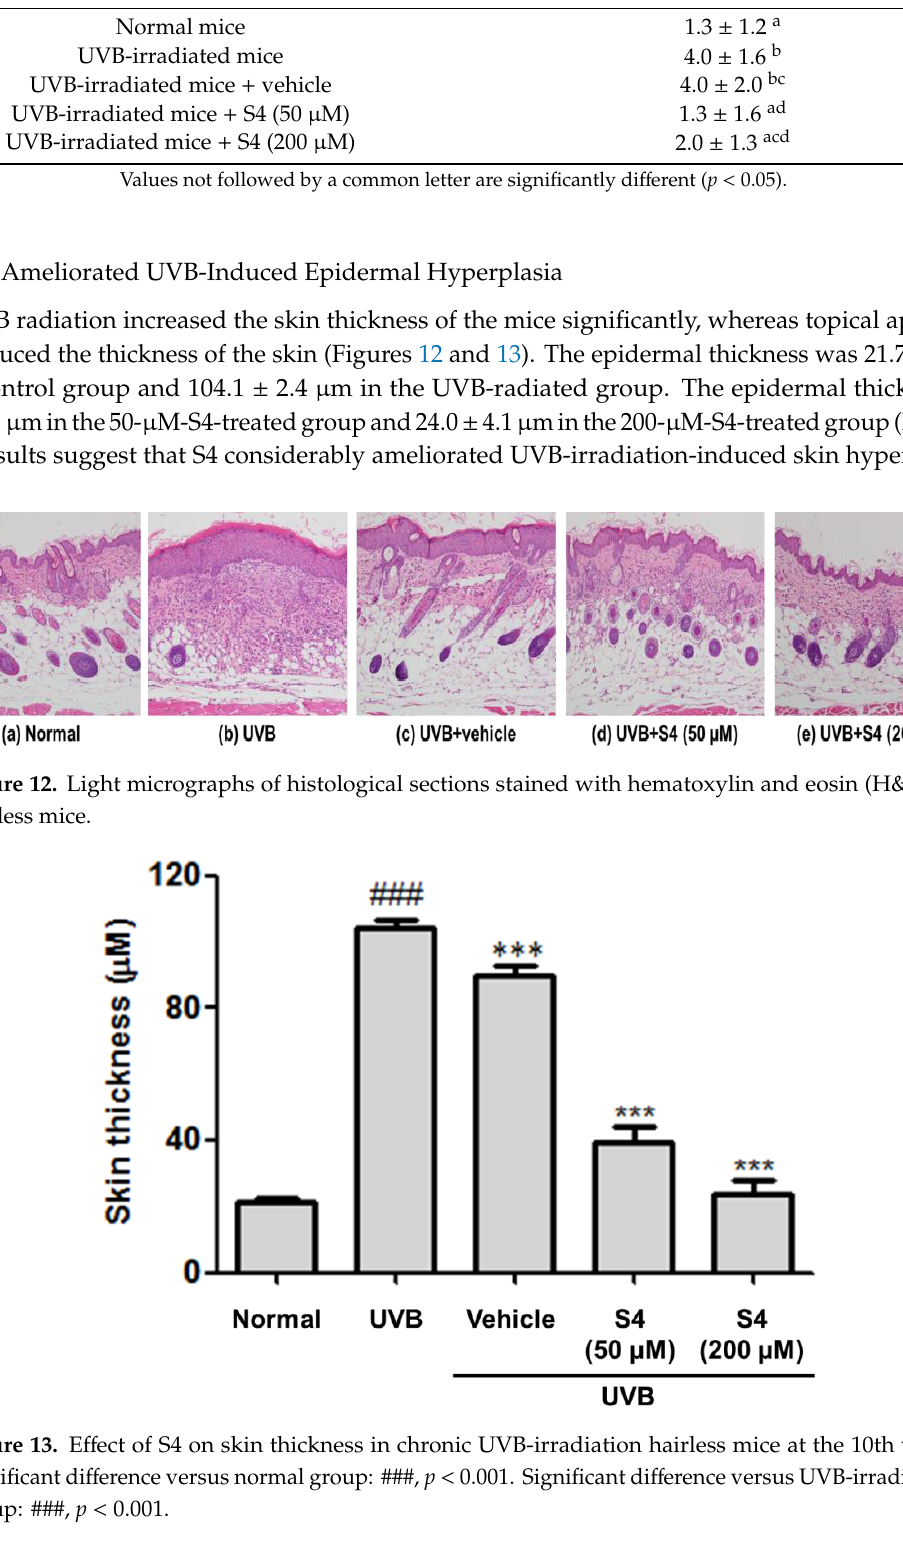
Table 1. Effect of sesamin on skin wrinkles induced by UVB irradiation in hairless mice. Table 1. E ff ect of sesamin on skin wrinkles induced by UVB irradiation in hairless mice.